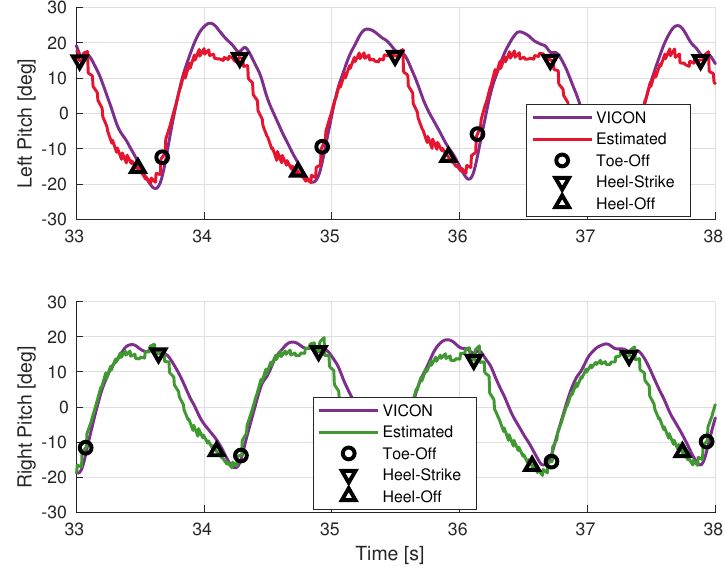
Figure 11. Comparison of thigh pitch angles during